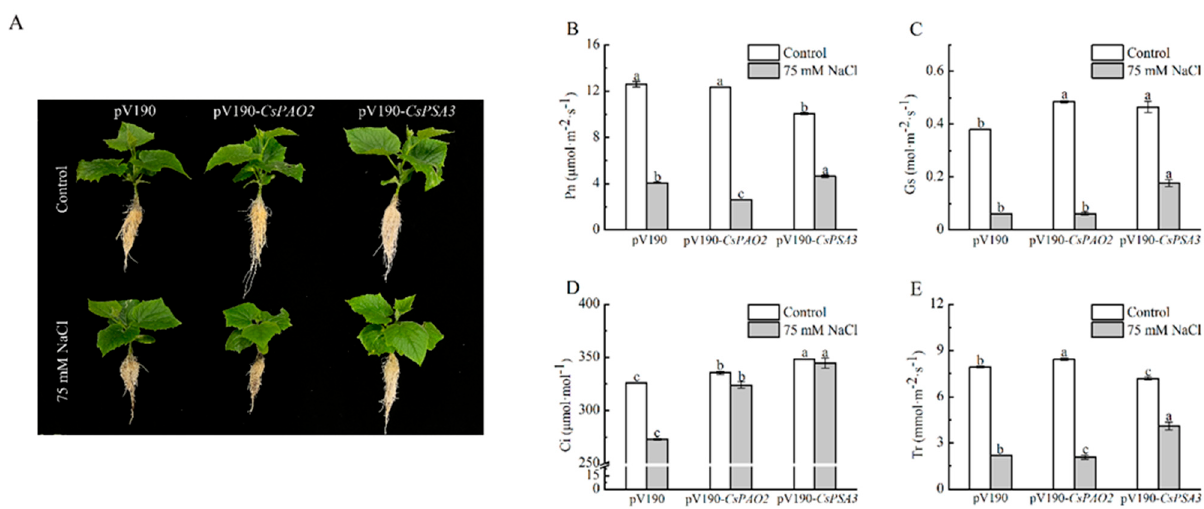
Figure 4. Effects of CsPAO2 and CsPSA3 silencing on photosynthesis of salt-treated cucumber. ( A ) Cucumber seedlings with or without NaCl treatment; ( B ) photosynthetic rate (Pn); ( C ) stomatal con- ductance (Gs); ( D ) intercellular CO 2 (Ci); ( E ) transpiration rate (Tr). Gene-silencing plants cultivated in nutrient solution were treated with 75 mM NaCl for 3 days. The different letters indicate signifi- cantly different test index values between different gene-silencing cucumber plants under the same treatment ( p < 0.05) according to Tukey’s test.